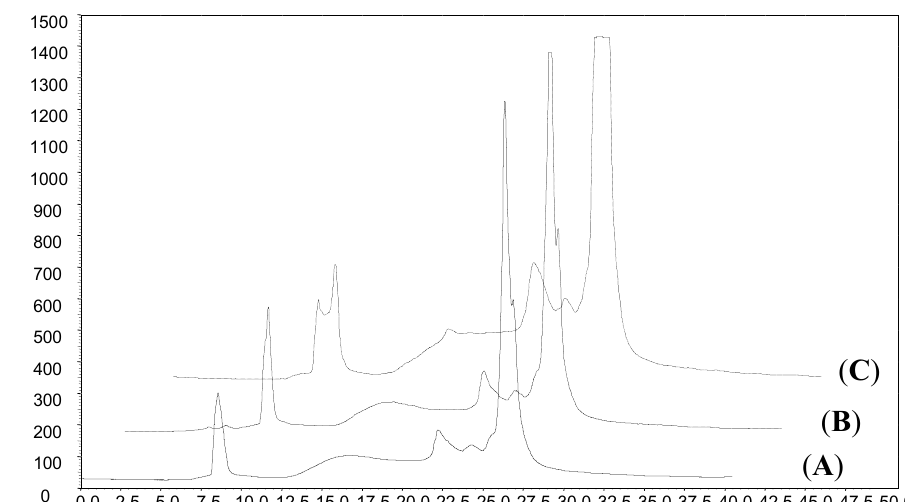
Figure 1. Chromatographic profiles of Kalanchoe pinnata leaf methanolic crude extract. Hypersil H5C18 (250 × 10 mm, 5 μ m) column with a water/methanol gradient elution: from 0–5 min: 5% MeOH, 5–30 min: 5%–100% MeOH, and 30–40 min: 100% MeOH. Flow rate 1 mL min − 1 , room temperature, detection λ = 254 nm, injection of ( A ) 0.66 mg ( B ) 1.32 mg ( C ) 2.64